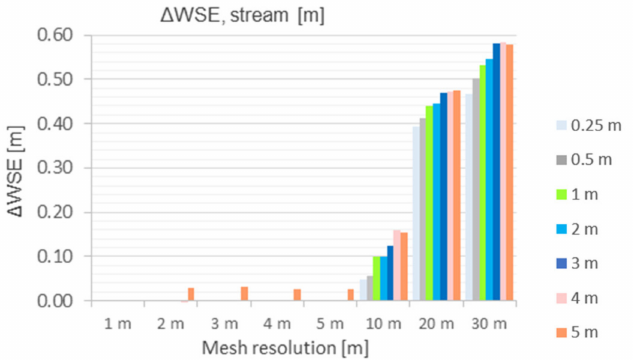
Figure 13. Overview of results of ∆ WSE at the control point in the stream for the different mesh and DEM resolutions (DEM: colored legend).